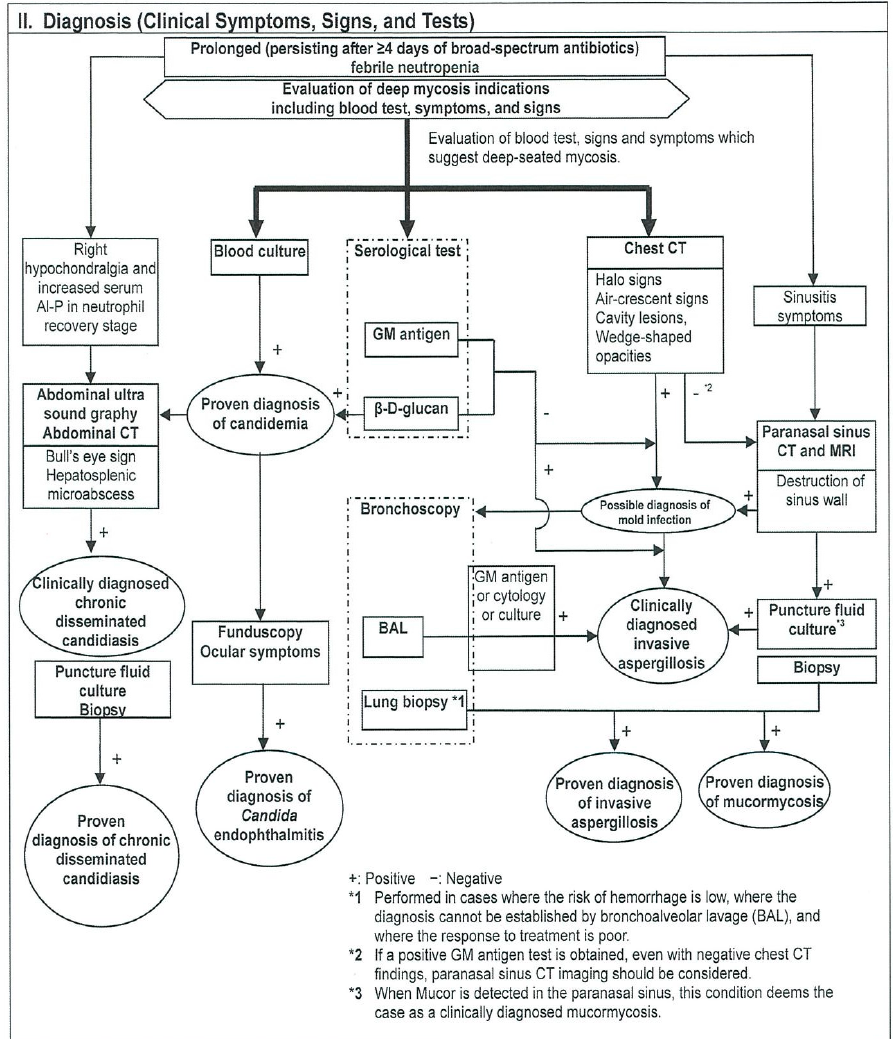
Figure 2. Flowchart for hematological disease.